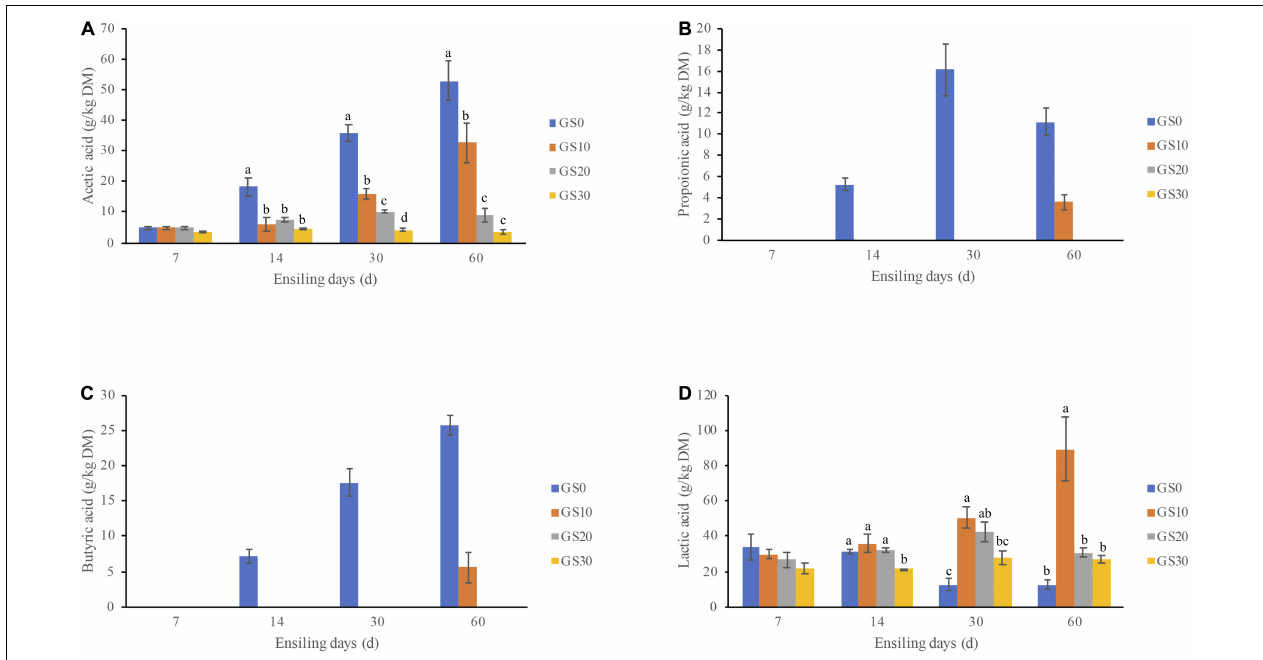
FIGURE 1 | Dynamic changes of organic acids, including acetic acid (A) , propionic acid (B) , butyric acid (C) , and lactic acid (D) of Pennisetum hydridum ensiled with garlic skin (GS0, 100 wt% Pennisetum hydridum ; GS10, 90 wt% Pennisetum hydridum + 10 wt% garlic skin; GS20, 80 wt% Pennisetum hydridum + 20 wt% garlic skin; GS30, 70 wt% Pennisetum hydridum + 30 wt% garlic skin). Different letters indicate a significant difference ( P <